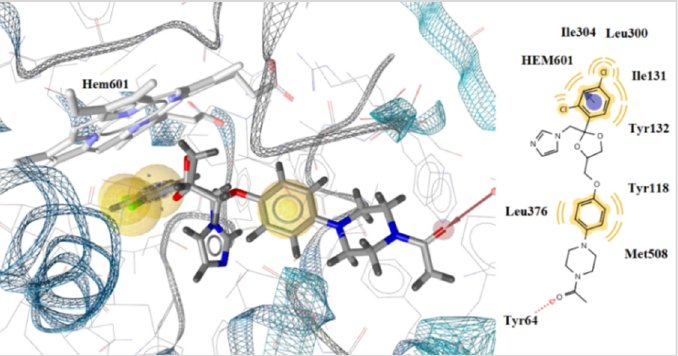
Figure 9. Docking pose of ketoconazole in the active site of C. albicans lanosterol 14alpha-demethylase (CYP51ca).